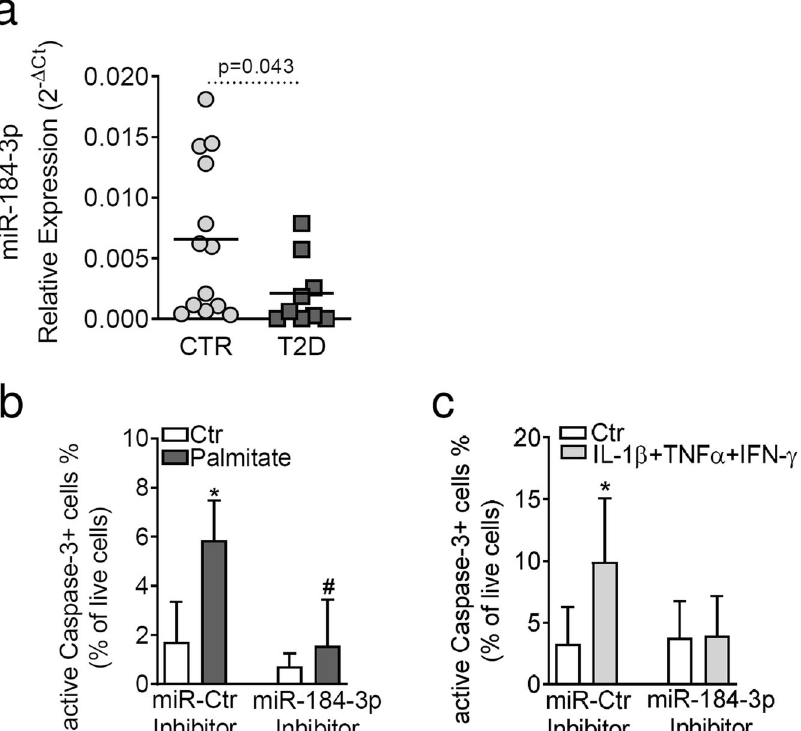
Fig. 1 miR-184-3p is downregulated in human pancreatic islets in T2D and protects β -cells from palmitate- and cytokine-induced apoptosis. a RT-Real-time PCR analysis of miR-184-3p expression in human T2D pancreatic islets ( n = 9; dark grey squares) and in non-diabetic ( n = 13; light grey circles) multi-organ donors; data are presented as 2 − Δ Ct relative expression single point values normalised with RNU44 and RNU48, along with the mean; statistics with Mann – Whitney U test. b Cyto fl uorimetric evaluation of cleaved Caspase-3 positive (cleaved-CASP- 3 + ) EndoC- β H1 cells each after 48 h palmitate treatment (* p = 0.0008 vs. untreated miR-Ctr inhibitor; # p = 0.0005 vs. Palmitate-treated miR-Ctr inhibitor transfected) and c after 24 h cytokine mix (IL -1 β + TNF- α + IFN- γ ) treatment (* p = 0.032 vs. untreated miR-Ctr inhibitor). Data are presented as mean ± SD of the percentage (%) of positive cells to total live cells. Statistics were performed using ANOVA analysis with Bonferroni ’ s multiple comparison test ( n = 4 independent